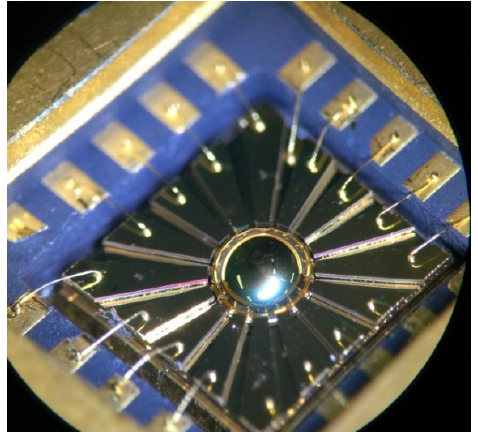
Figure 9. Physical photo of μ HR after wire-bonding.